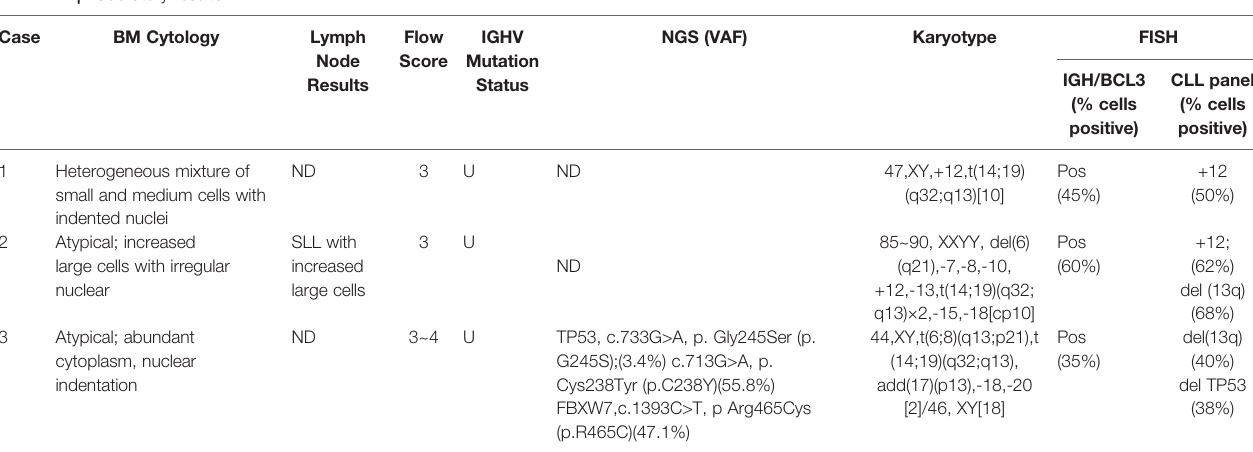
TABLE 2 | Laboratory